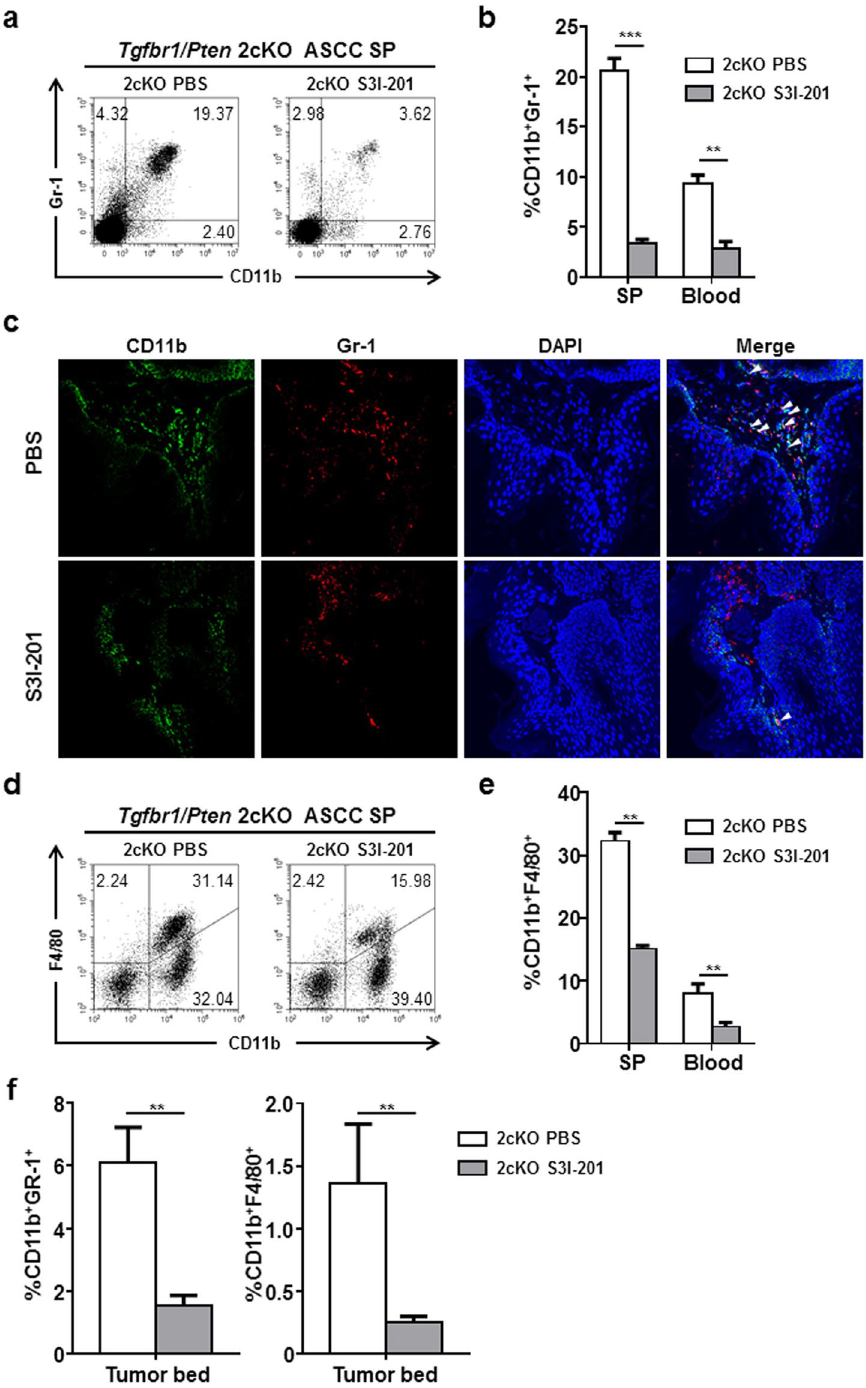
Figure 5. Inhibition of STAT3 reduced MDSC and TAM population in mice with ASCC. ( a ) MDSC population was monitored by CD11b + Gr-1 + flow cytometry in peripheral blood and spleen. S3I-201 treatment notably reduced the proportion of MDSCs in total lymphocytes. ( b ) Quantification of the results. ( c ) Representative immunofluorescent staining of CD11b + Gr-1 + in mice ASCC. Visible reduction of MDSCs populations in the S3I-201 treatment group was seen. ( d ) TAM population was monitored by CD11b + F4/80 + flow cytometry in peripheral blood and spleen. S3I-201 treatment notably reduced the proportion of TAMs in total lymphocytes. ( e ) Quantification of the results. ( f ) CD11b + Gr-1 + and CD11b + F4/80 + populations in the tumor bed were significantly reduced after S3I-201 treatment. ** P < 0.01; *** P <